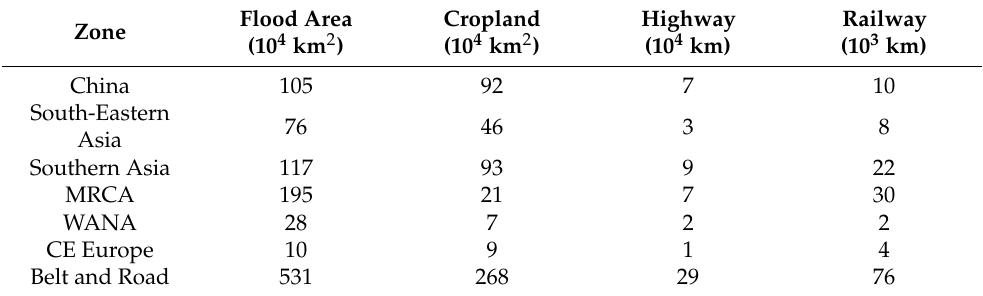
Figure 6. ( a ) spatial distribution of floods in 2016 along the “Belt and Road” zone; ( b ) potential affected cropland by floods in 2016 along the “Belt and Road” zone; ( c ) potential affected railway by floods in 2016 along the “Belt and Road” zone; ( d ) potential affected highway by floods in 2016 along the “Belt and Road” zone. Table 5. Potential affected cropland/railway/highway by floods in 2016 along the “Belt and Road”